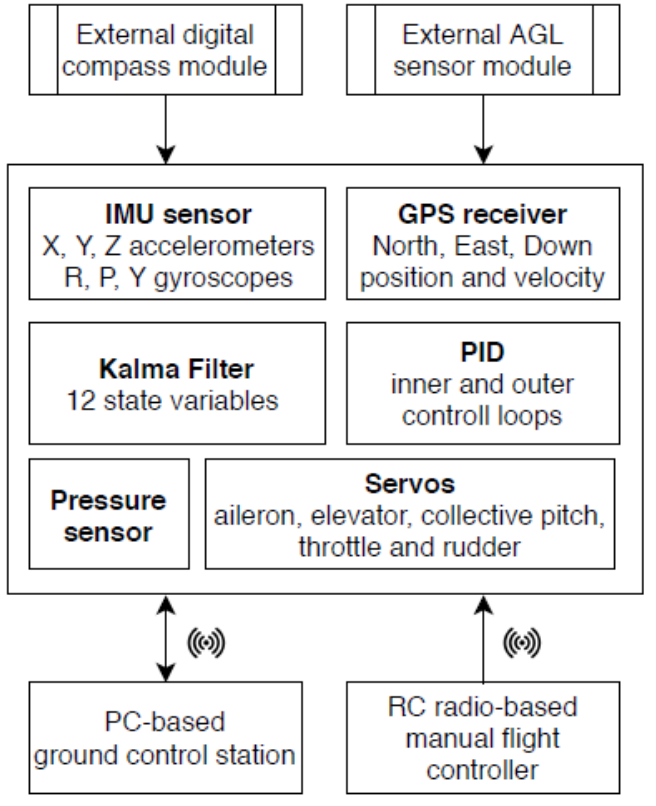
Figure 2. Flight control system architecture.